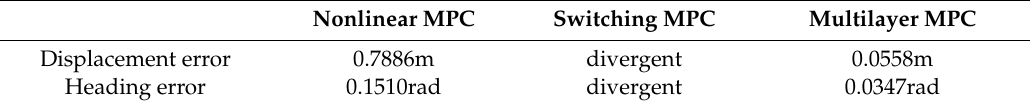
Figure 8. Displacement error of the comparison between controllers. Figure 9. Heading error of the comparison between controllers.